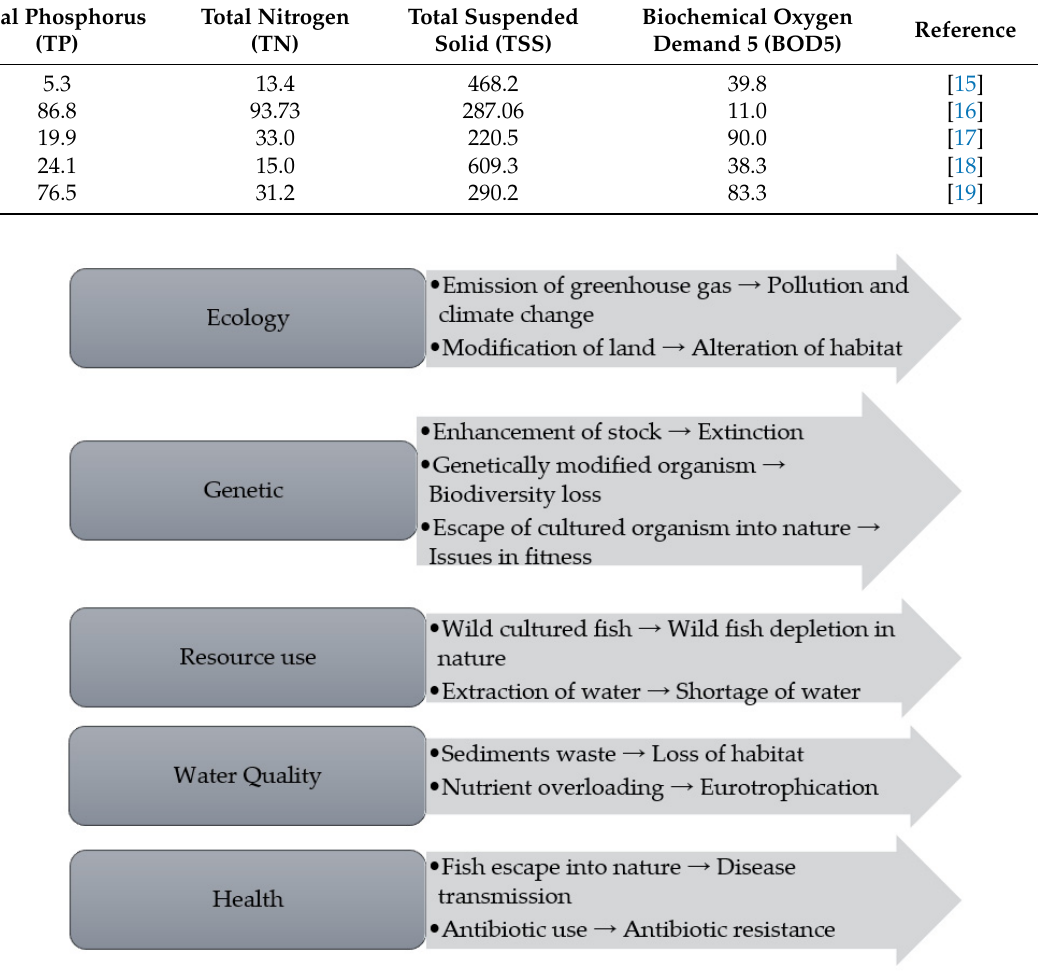
Table 1. Average load of nutrient during cultivation of certain farmed fish (kg/tonne of product).